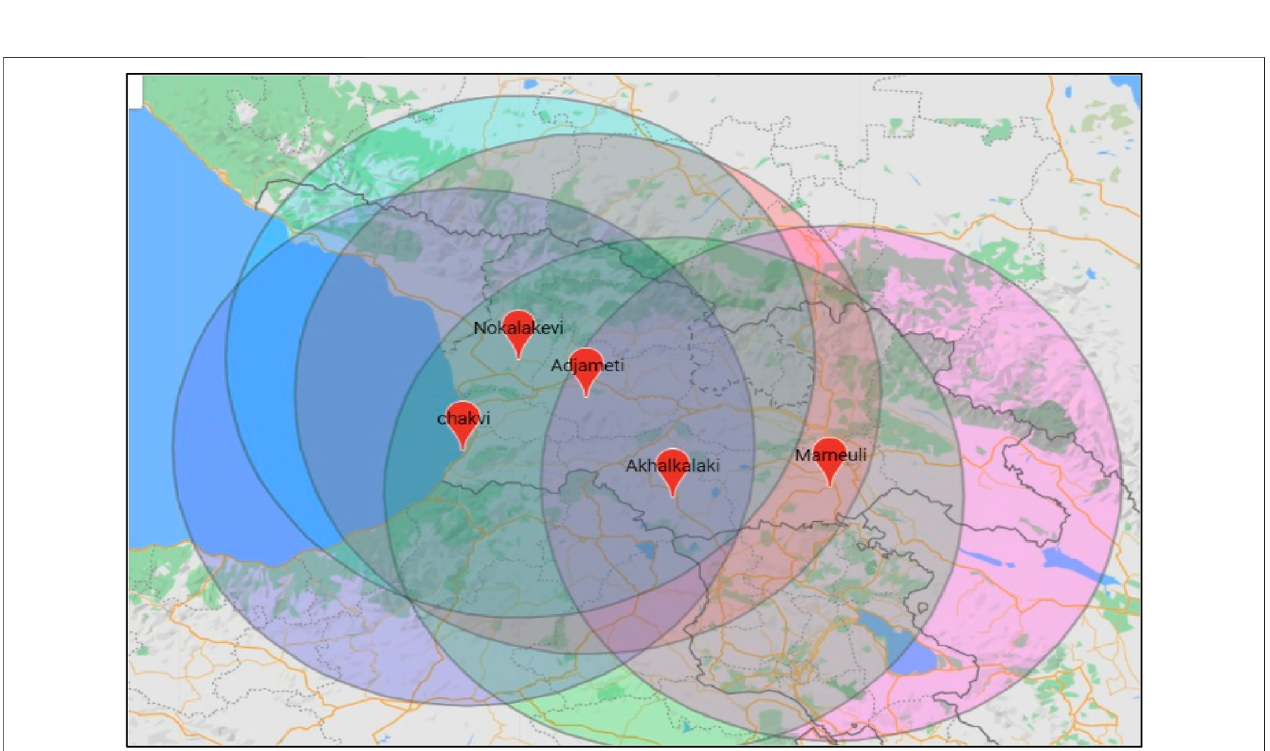
FIGURE2| Weightsofdifferentstatisticalmeasuresobtainedintheprocessofmachinelearningusingaverageinputdataforall fi veregions(bluecolumns).Thered curve shows the cumulative percent of separate weights.